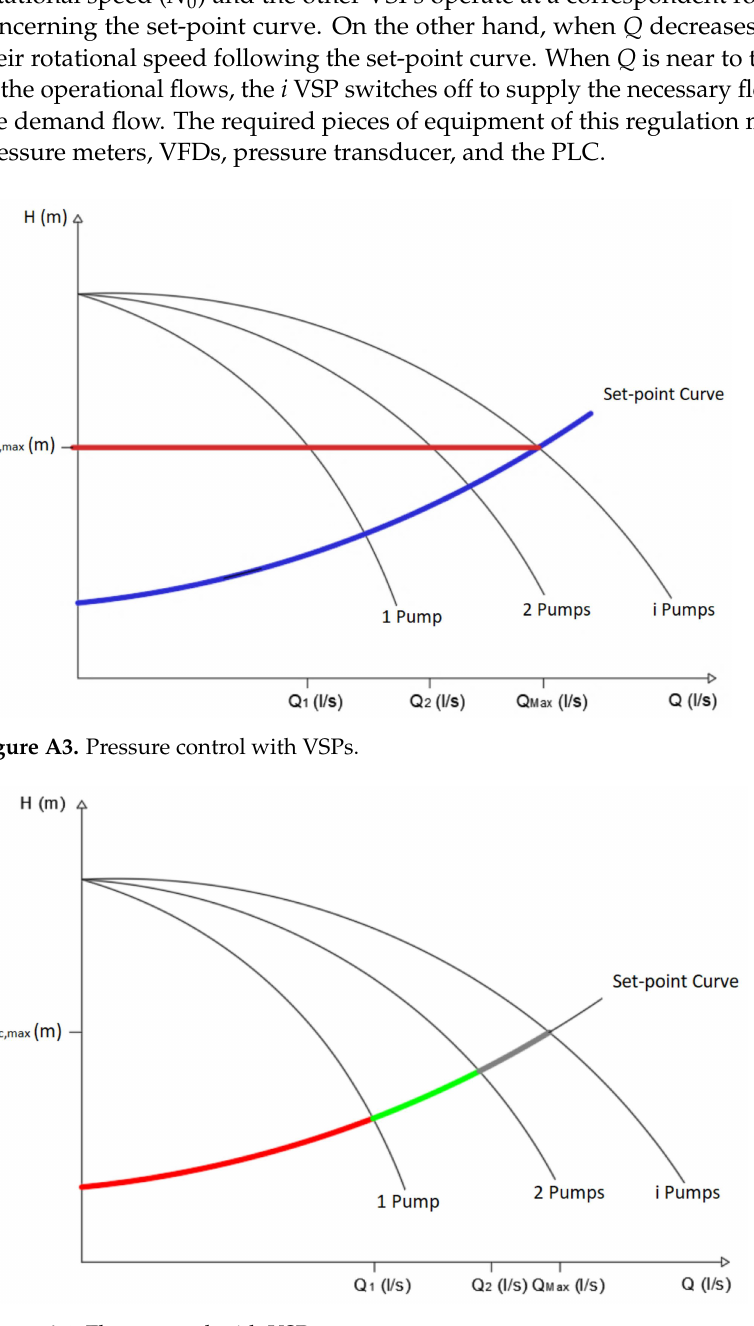
Figure A4. Flow control with